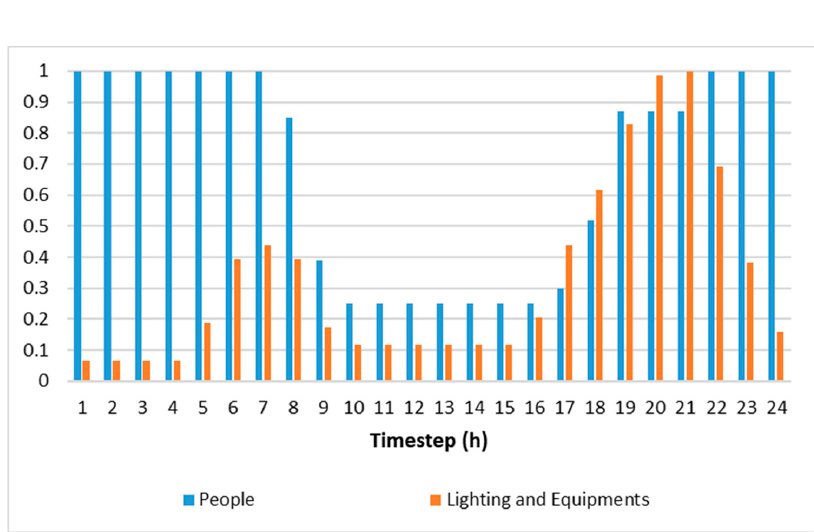
Figure 4. People, lighting, and appliances hourly schedules during a typical